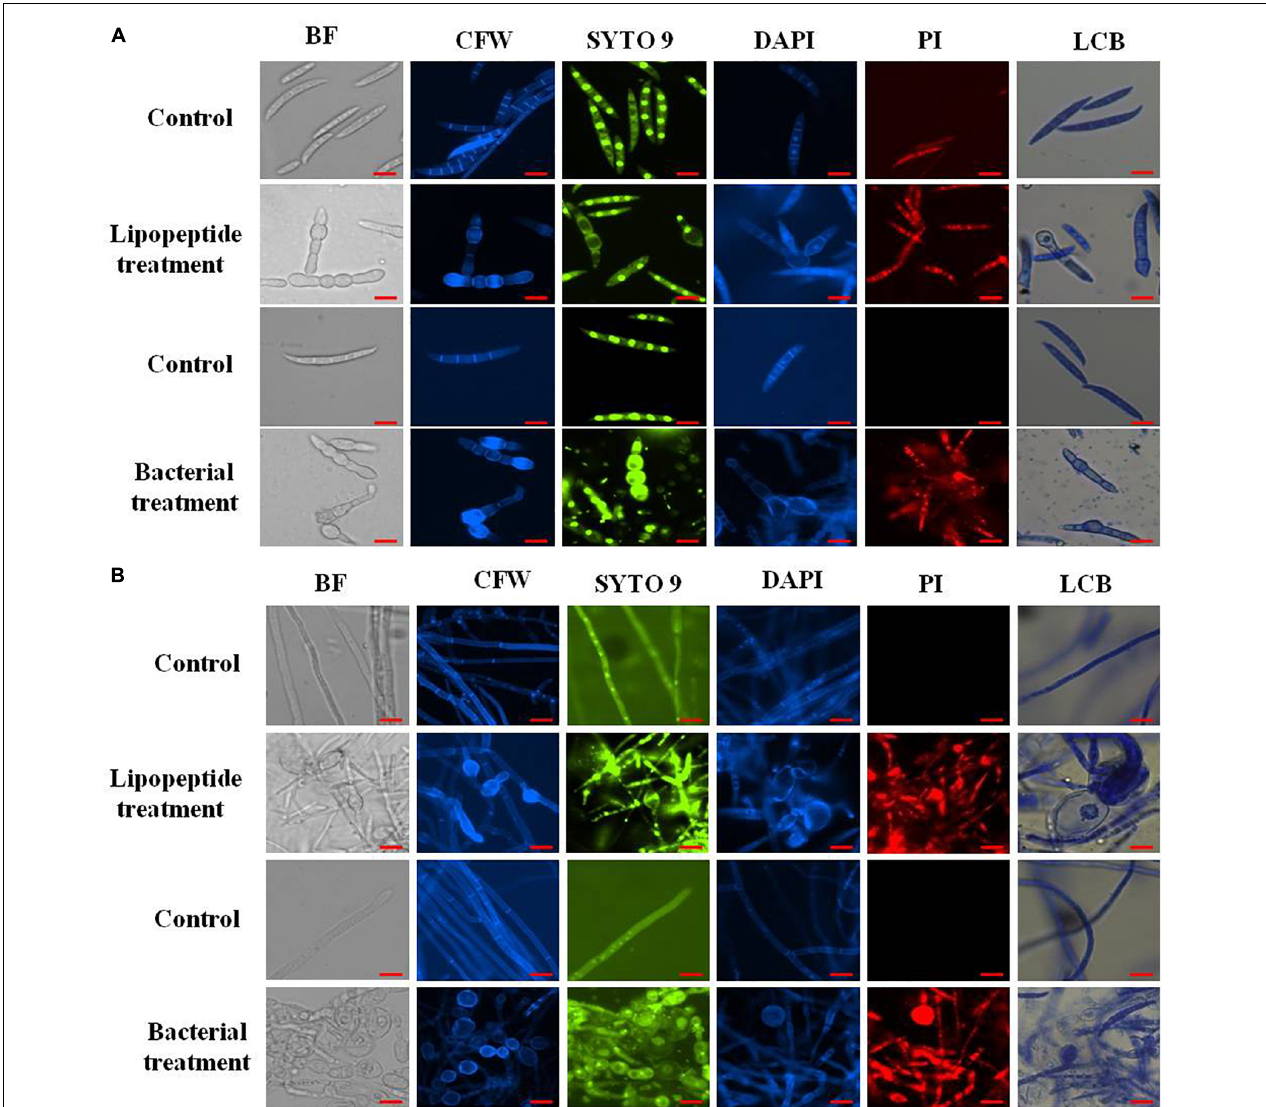
FIGURE 7 | Closer view of effect of bacterial ( Bacillus subtilis ) and lipopeptides on fungal spores (A) and hyphae (B) of Fusarium sp. under bright field, fluorescent microscopy (CFW, Syto-9, DAPI, and PI) and lactophenol cotton blue (LCB) light microscopy. Bacterial treatment was done by co-cultivation of Fusarium with Bacillus subtilis in mixed media of nutrient and potato dextrose agar/broth. Lipopeptide treatment was done by disc diffusion (each disc contain 20 µ l of 10 µ g µ l − 1 methanolic solution of lipopeptide), hyphae and spores growing near the disc was taken for microscopy. In control-A fungus was not challenged with bacteria and control B- disc was only loaded with 20 µ l of methanol without lipopeptide (Scale bar = 10 µ